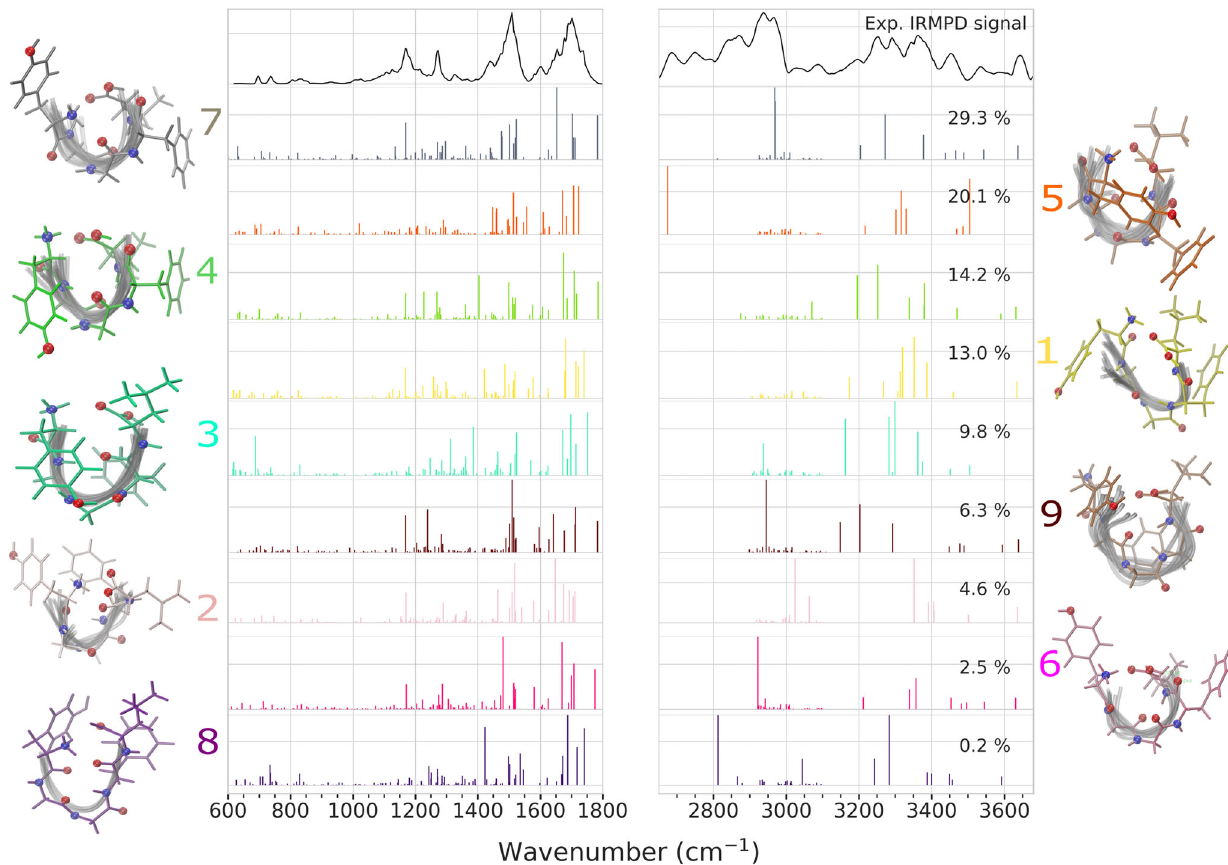
Fig. 4 IR spectra of all PAMM conformer clusters and IRMPD spectrum. Spectra are colored according to the assigned representative conformer of each cluster, which is shown next to the corresponding spectrum. Associated weights of each conformer cluster are shown in each